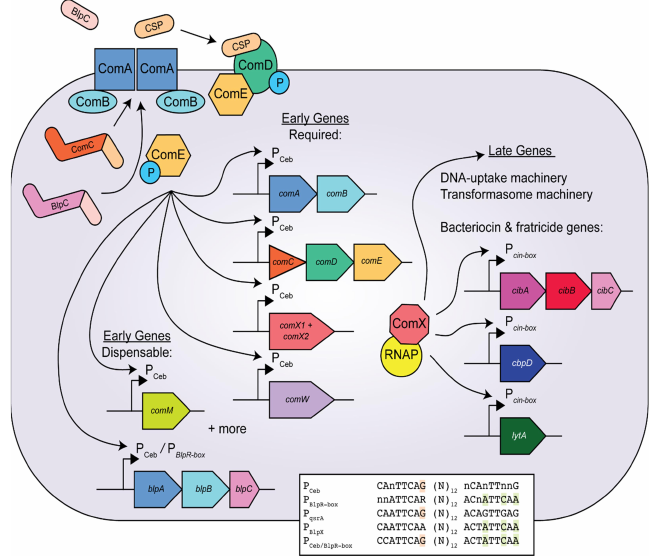
Figure 1. The ComABCDE quorum sensing (QS) pathway of Streptococcus pneumoniae . The two phases of competence development are controlled by ComE, for induction of early genes, and by